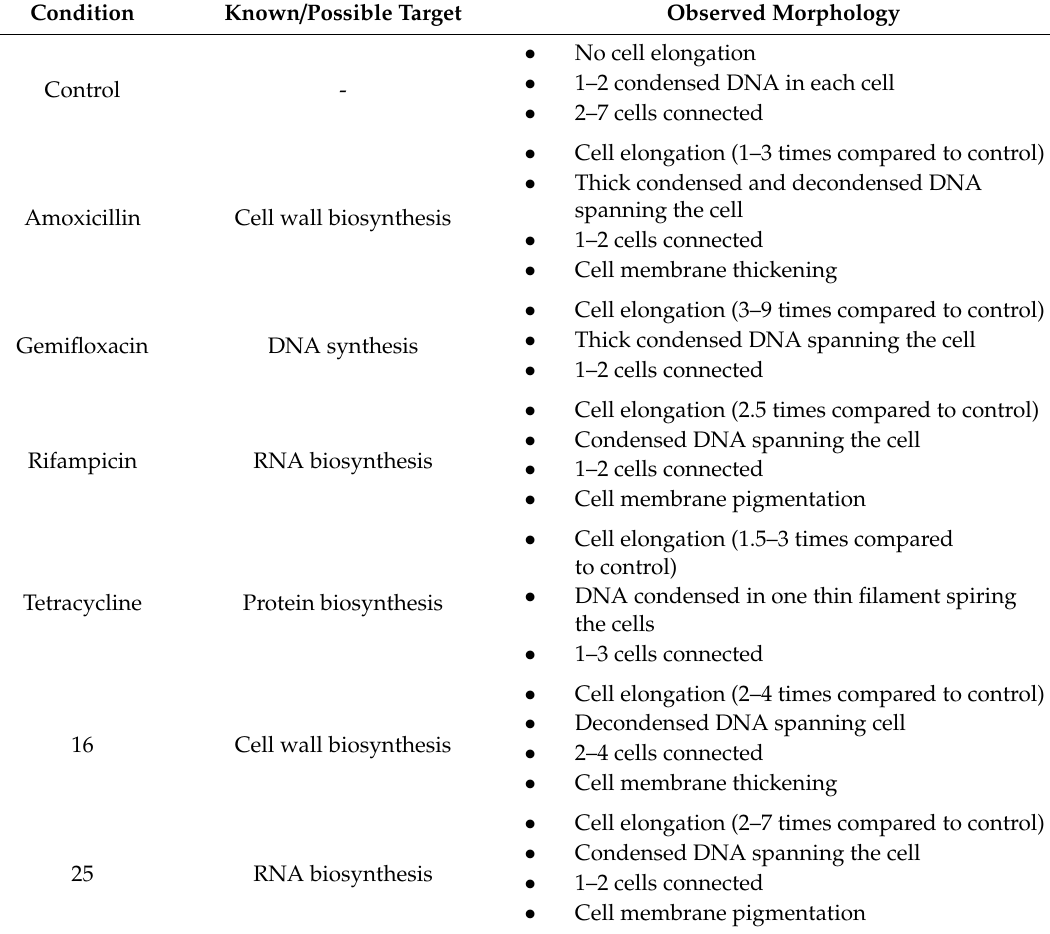
Table 6. Description of the morphological changes caused by conventional antibiotics or berberine’s derivative 16 and 25 in V. alginolyticus . Morphological changes of V. alginolyticus caused by conventional antibiotics and compounds 16 or 25 illustrated in Figures 10–12 are summarized in this